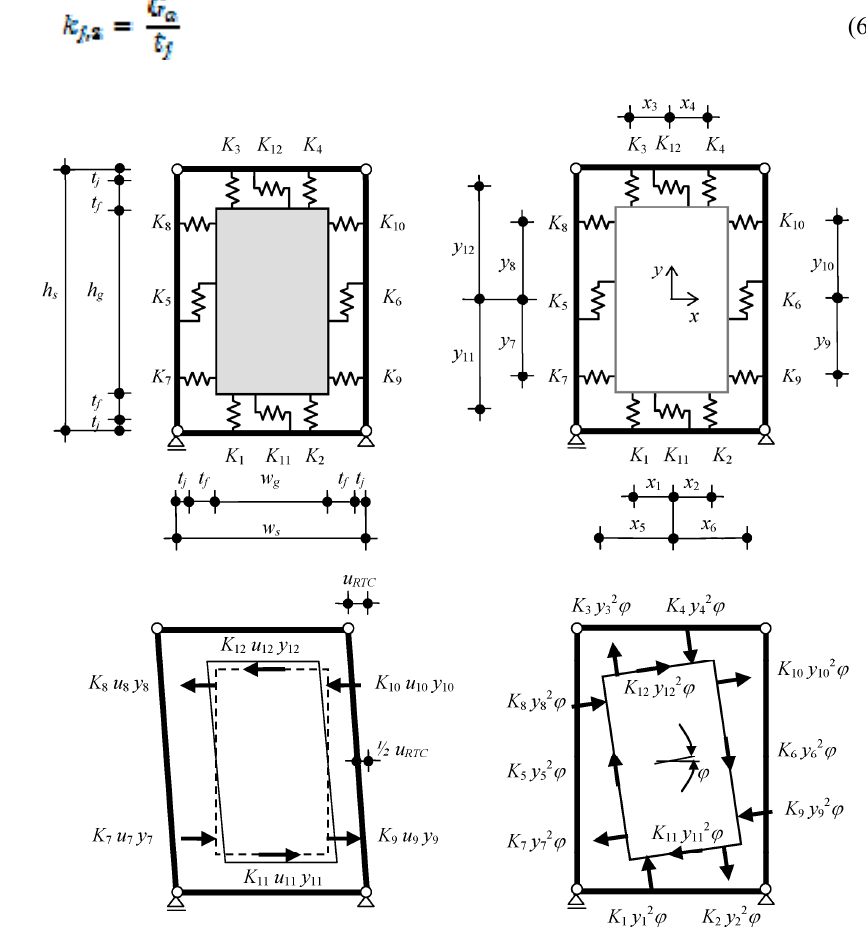
Figure 2: Mechanical model (adapted from